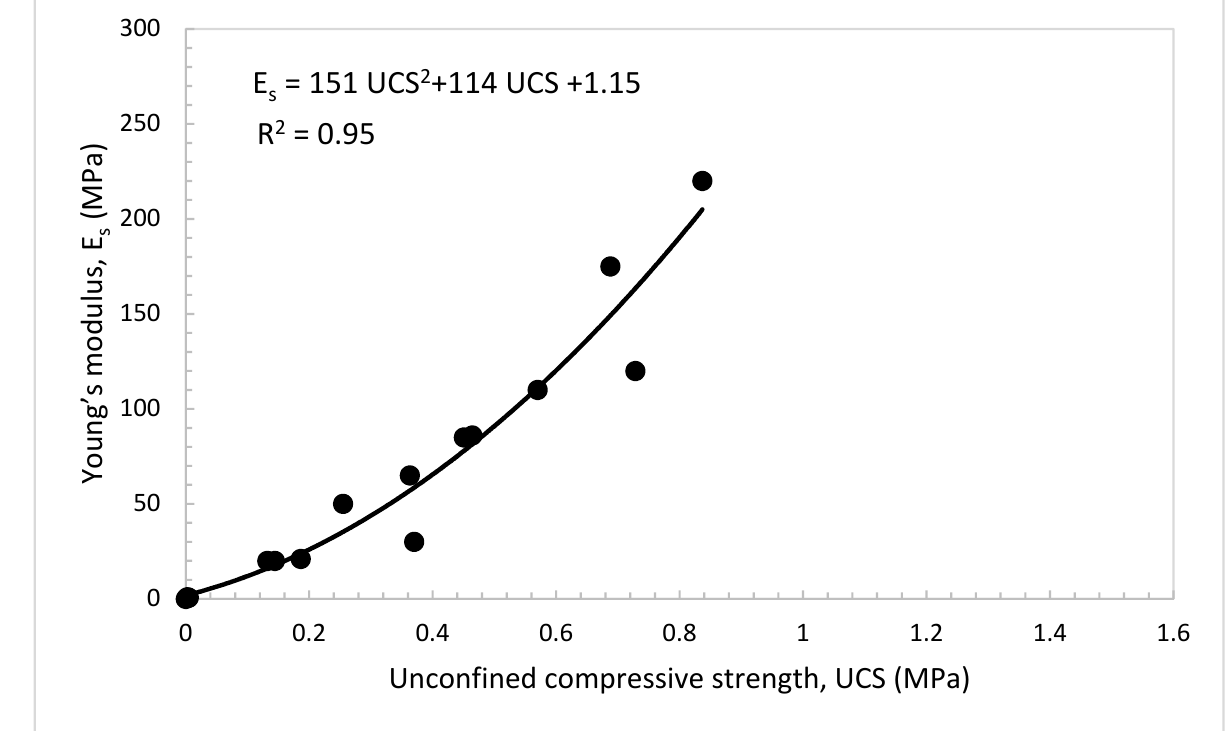
Figure 16. Young’s modulus, E s vs. unconfined compressive strength of the treated dune sand.